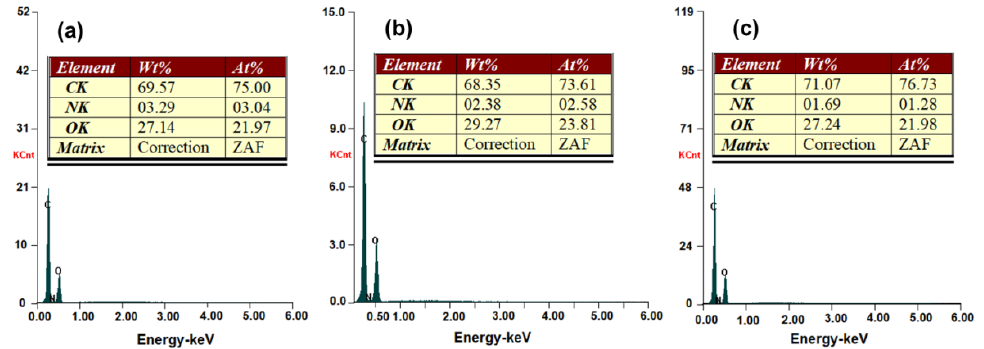
Figure 9. EDX analysis for PHEMA/P4VP ( a ), PHEMA/P4VPB-1 ( b ) and PHEMA/P4VPB-2 ( c ) semi- IPNs (TEGDMA:HEMA = 1:50, mol/mol; HEMA:linear polymers = 1:0.5 g/g, solvent of linear polymer = ethanol:sodium bicarbonate (40:60, v / v ).